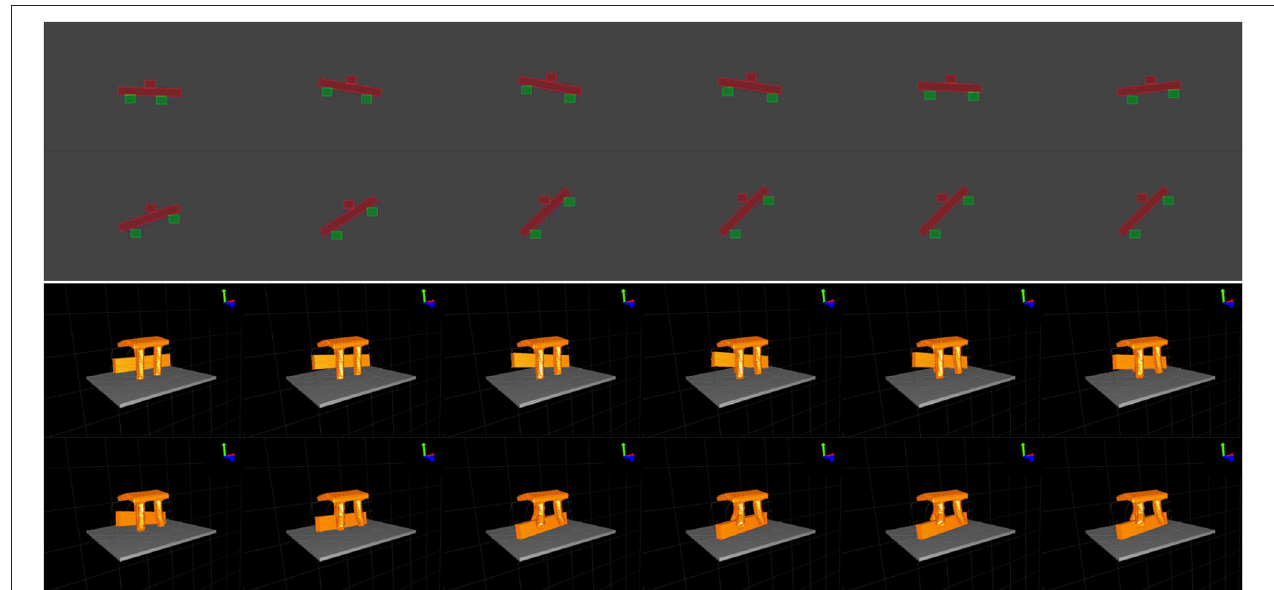
FIGURE 5 | From left to right and top to bottom, frames captured from 2D and 3D simulated manipulations.